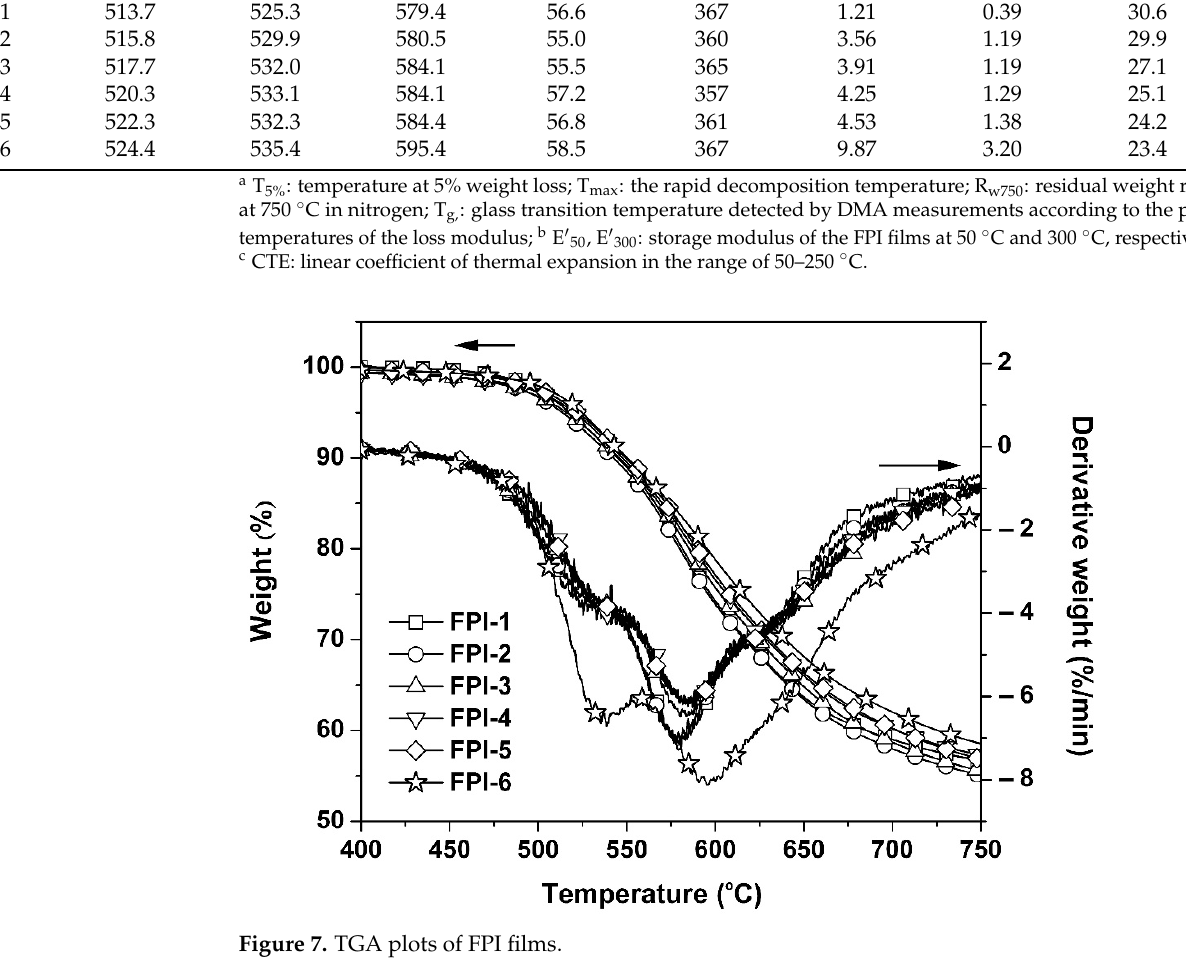
Figure 7. TGA plots of FPI films.